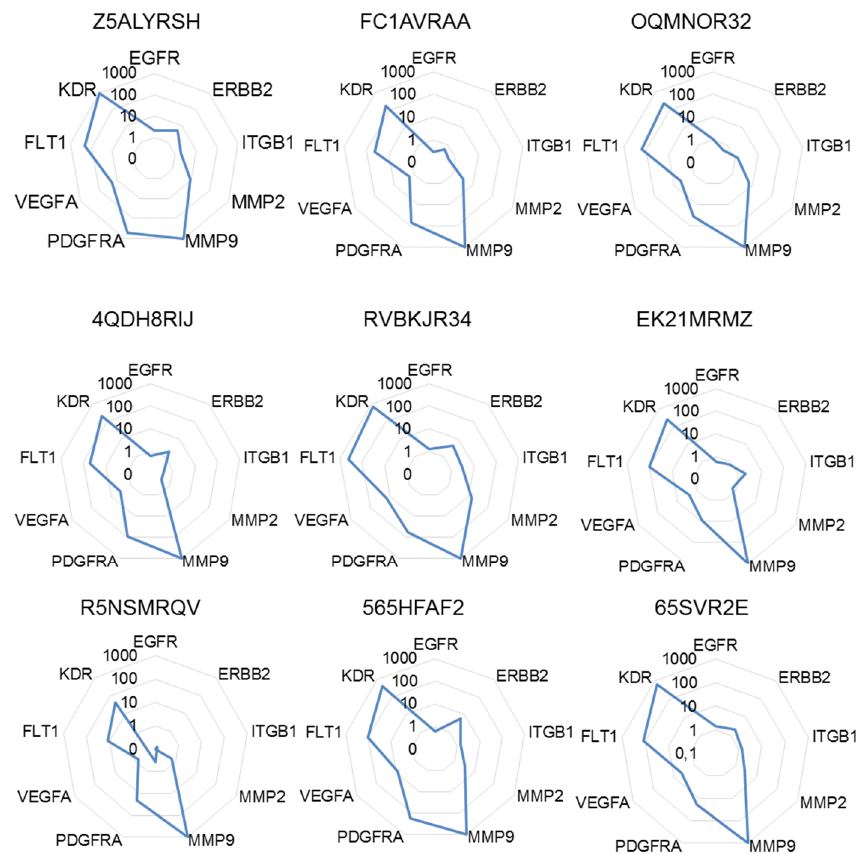
Figure 3. Molecular signatures after multiple normalizations. The different radar graphs are showing the molecular signature of each tumor sample when expression data were expressed as the sum of 2 −ΔΔCt further normalized to 1000, an arbitrary unit attributed to the gene with the highest sum of 2 −ΔΔCt .